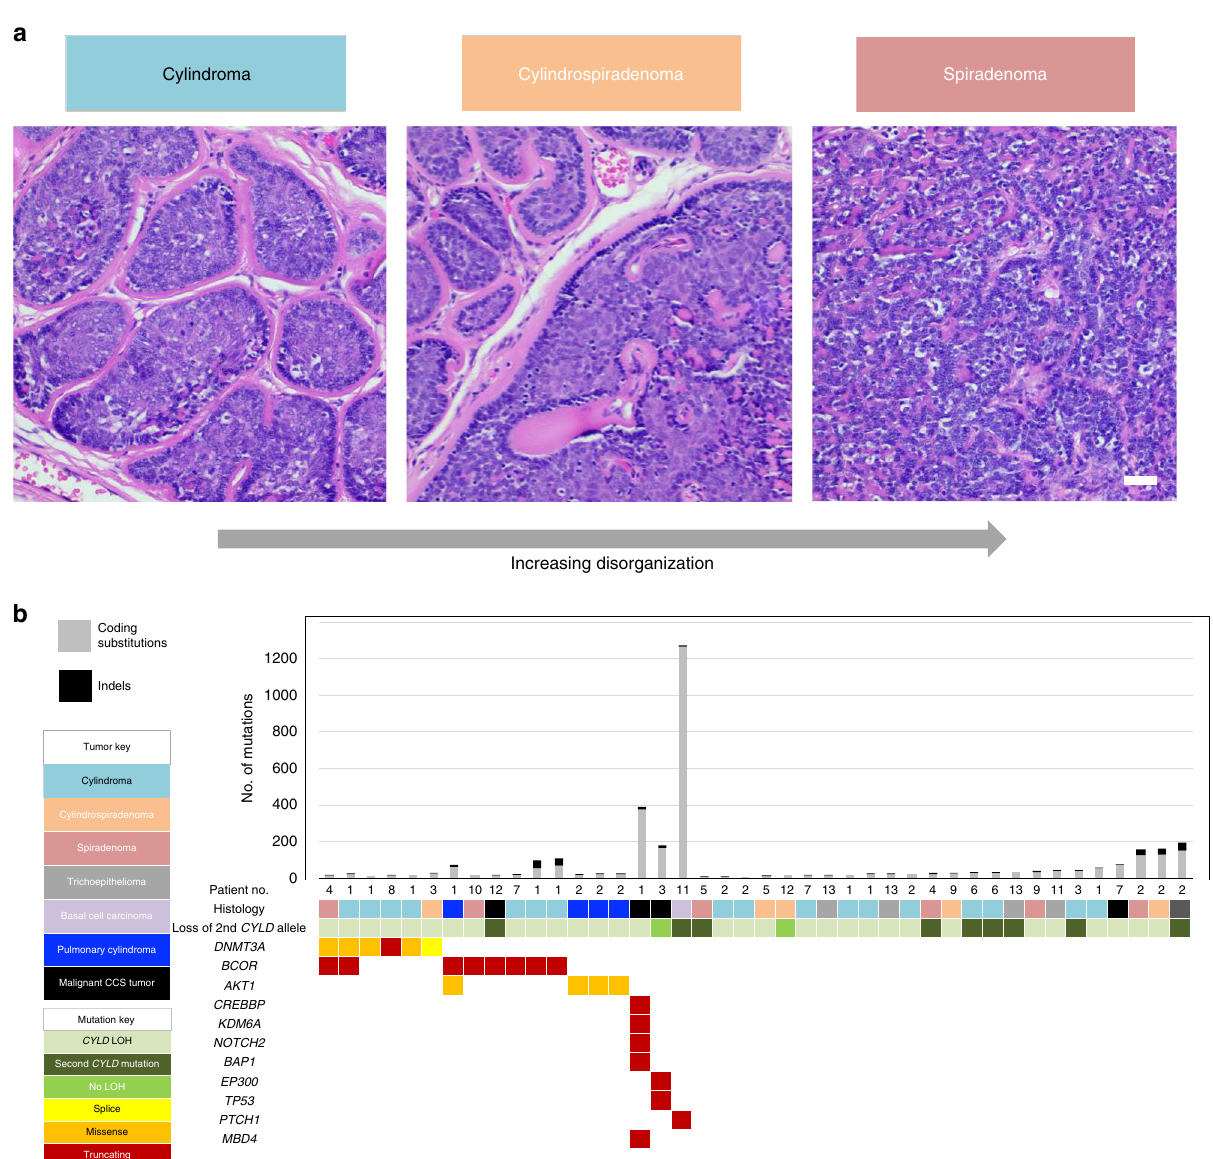
Fig. 1 The mutational landscape of CYLD cutaneous syndrome. a Distinct histophenotypes of benign organized cylindroma and disorganized spiradenoma seen within the same sample, a frequent fi nding in CCS (white scale bar = 50 μ m). b Epigenetic modi fi ers are mutated in CCS tumors. Mutational burden is indicated in the bar graph with corresponding mutated genes shown below in the matrix. Matrix rows indicate mutated genes in each tumor and each matrix column represents a different sample ( n = (Fig. 2d and Supplementary Fig. 4a, b). DNA was extracted from was performed. In three tumors, there was an identical DNMT3A mutation in both regions. In two tumors, there was heterogeneity between the histophenotypes, with private mutations in each regions, suggesting that multiple DNMT3A mutant clones of different sizes exist within tumors.